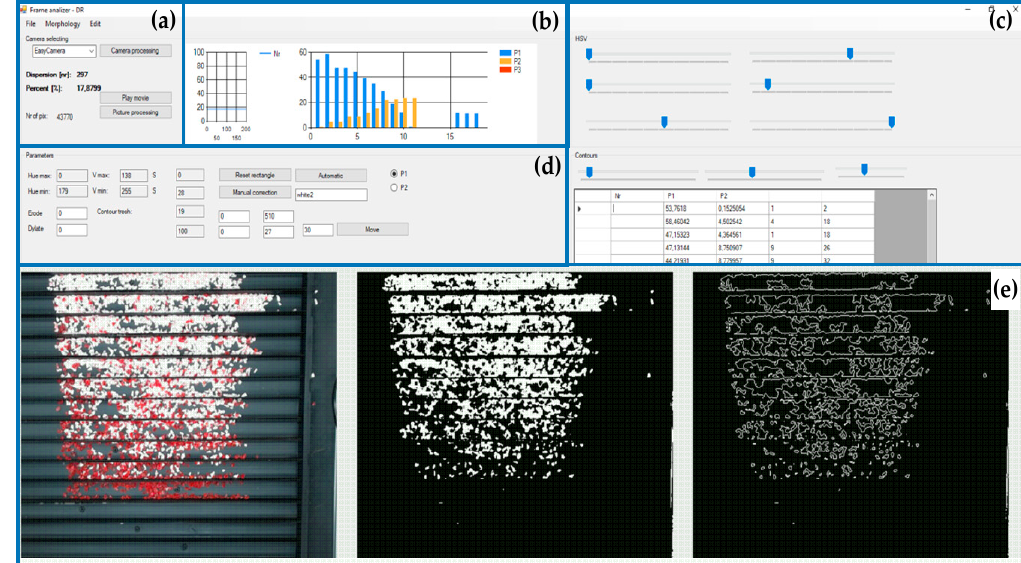
Figure 4. Material pickup consisting of 18 regions of interest (ROIs) filled with sample materials: ( a ) camera selection, ( b ) data visualization (preview), ( c ) HSV colour settings, ( d ) ROI parameter selection, ( e ) camera view (before and after image processing).